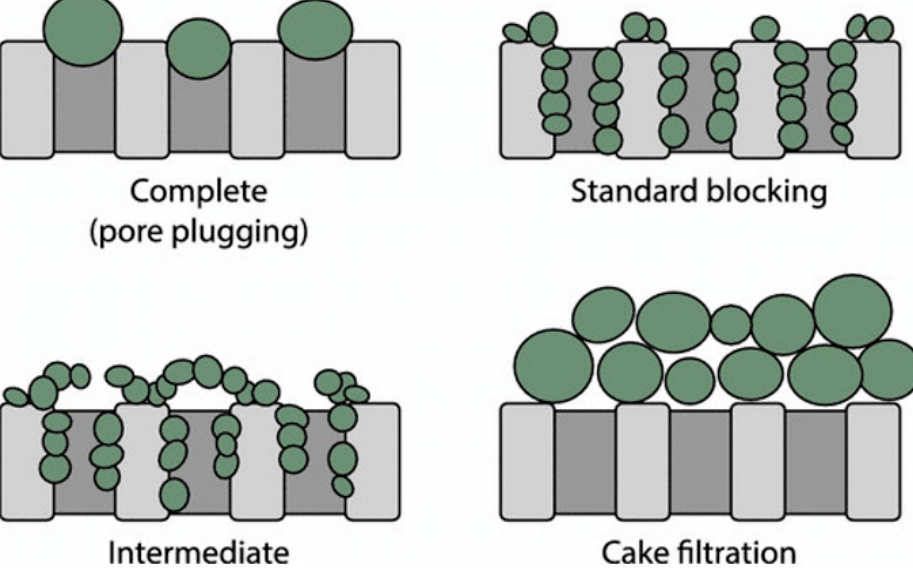
Figure 2. Illustration of several membrane fouling mechanisms [72].